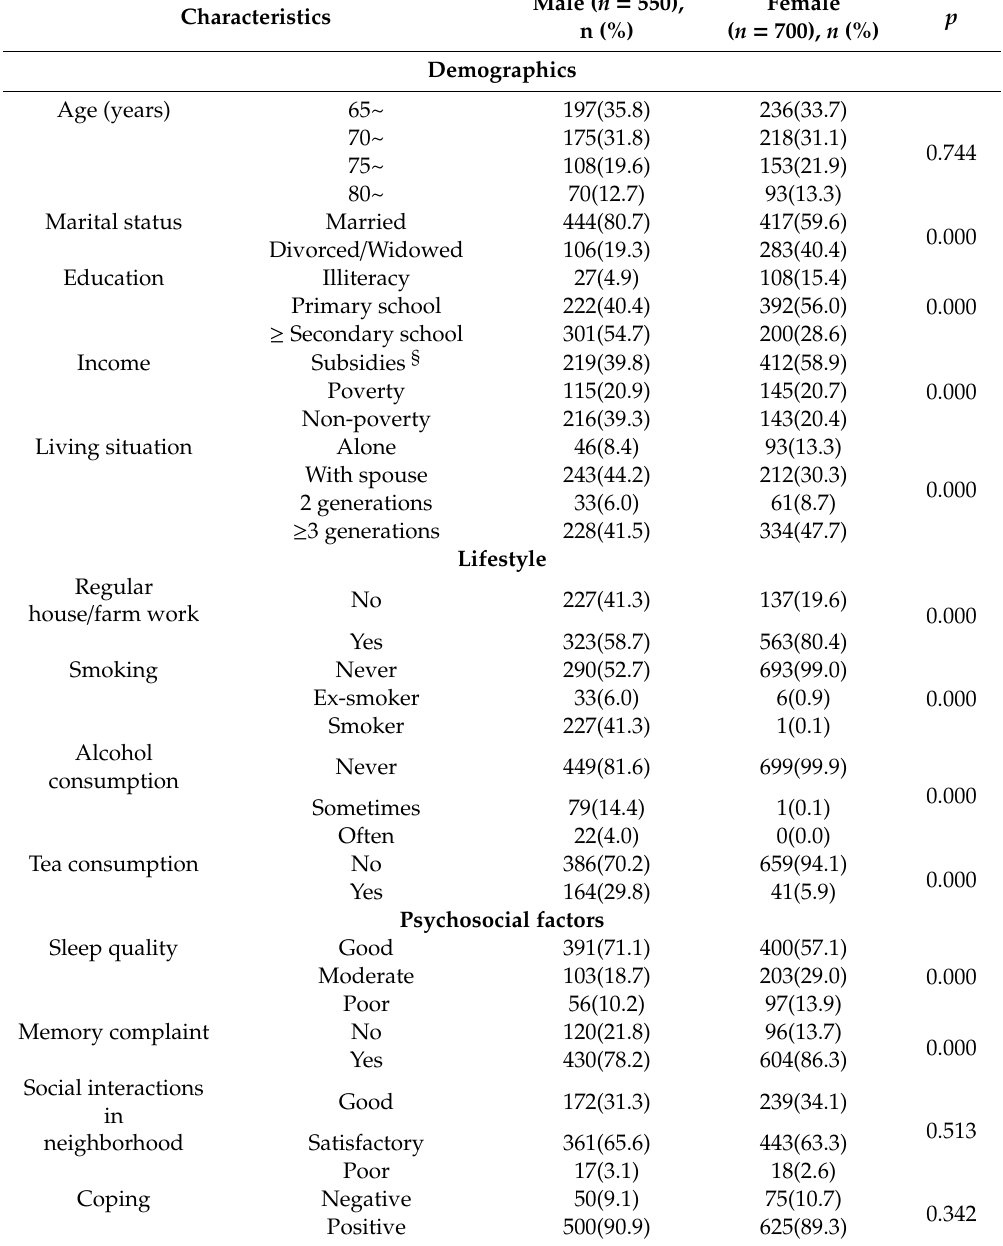
Table 1. Major characteristics of study